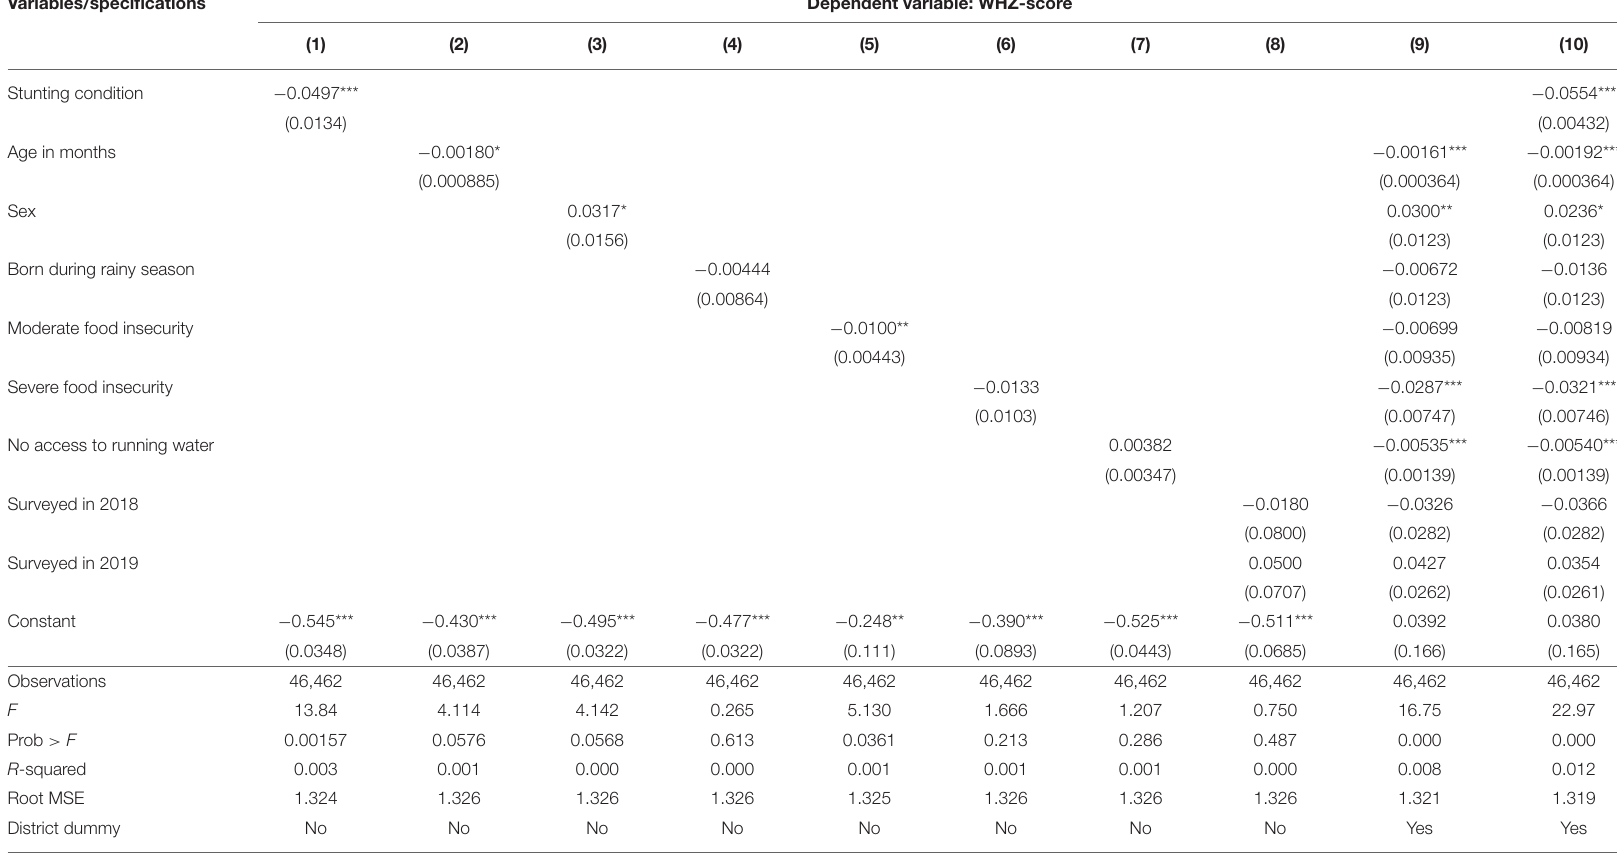
TABLE 9 | Linear regression models for the weight-for-height